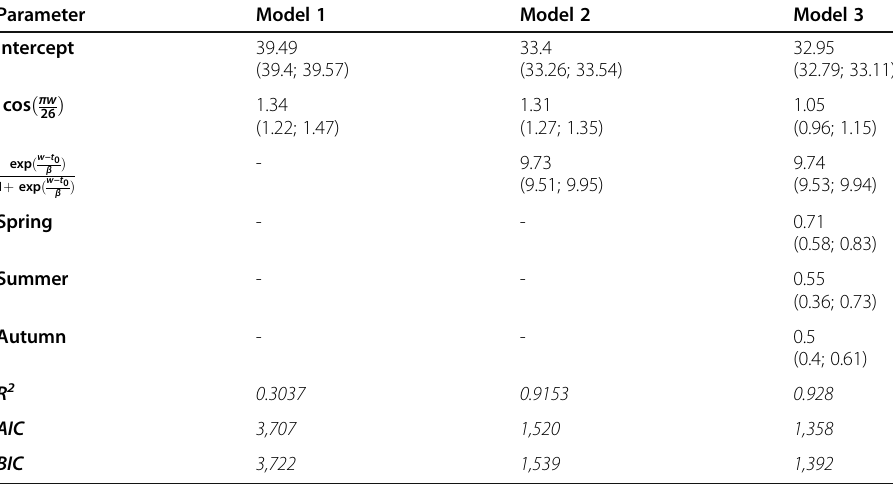
Table 1 Iterative trend function coefficients with 95% CIs to Lee-Carter Index